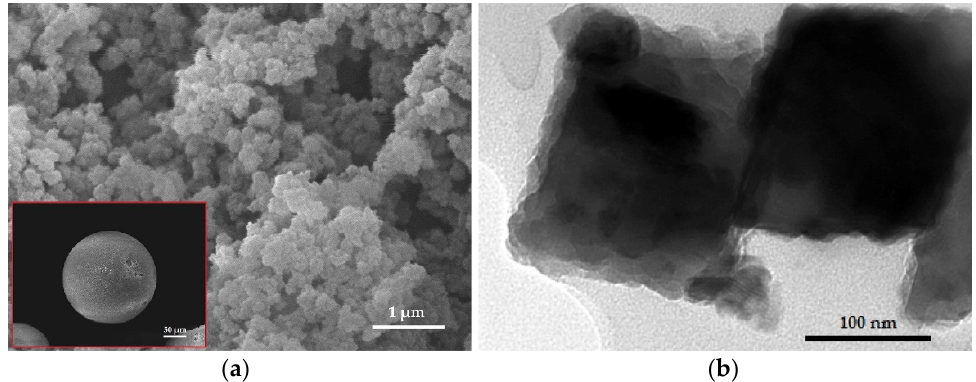
Figure 1. ( a ) SEM image of cross-section (WD 11 mm, scale bar 1 μ m, magnification 20,000×) and ( b ) TEM image (horizontal field width 436.9 nm, scale bar 100 nm, magnification 120,000×) of Fe 3 O 4 @APTMS/PGME-deta. Inset: SEM image of Fe 3 O 4 @APTMS/PGME-deta bead (WD 11 mm, scale bar 50 μ m, magnification 300×).